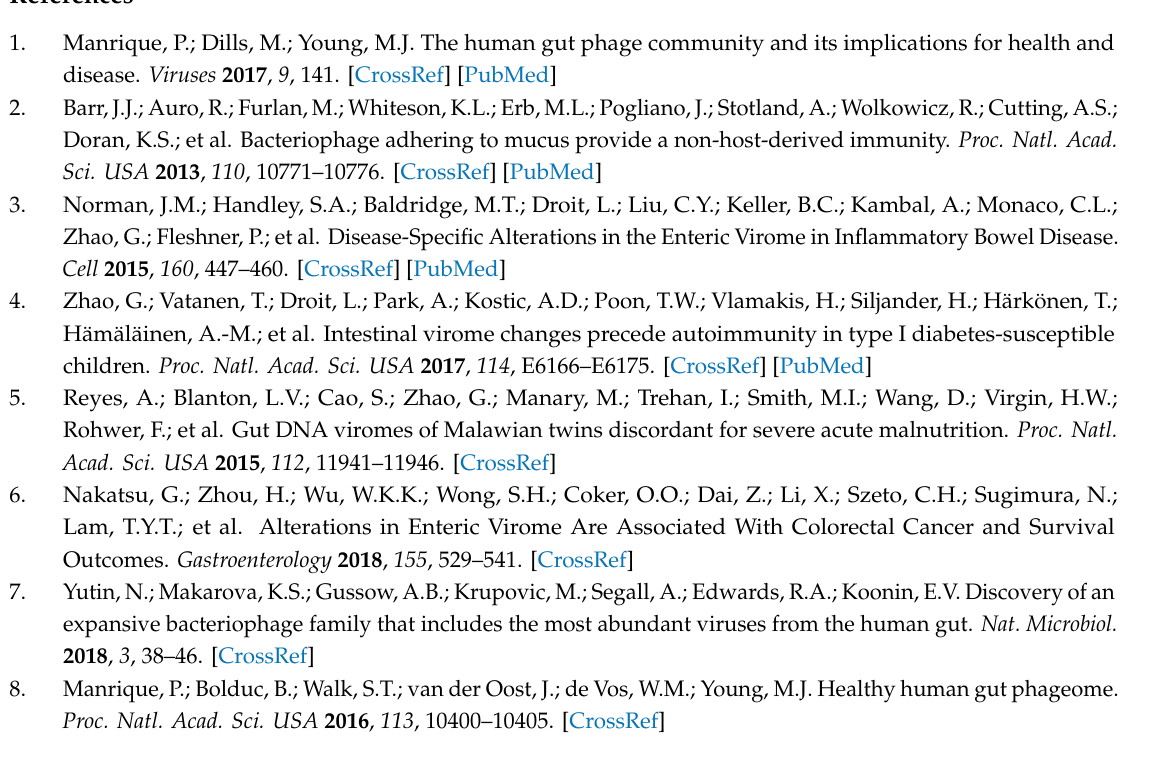
Figure S1: Silhouette plot of the seven crAss-BACON-containing contig clusters shows that cluster 6 is weakly clustered due to heterogeneity, Figure S2: Cluster 1 crAss-BACON ORFs are conserved, except for their C-termini, Figure S3: A similarity matrix of crAssphage BACON tandem repeats shows that the tandem array expansion occurred through single domain duplication events, Figure S4: The same approximate likelihood tree as depicted in Figure 5a, but without collapsed branches, Table S1: crAss-BACON containing contigs, Table S2: crAss-BACON domains, Table S3: Annotation of cluster A contig, Table S4: Annotation of cluster B